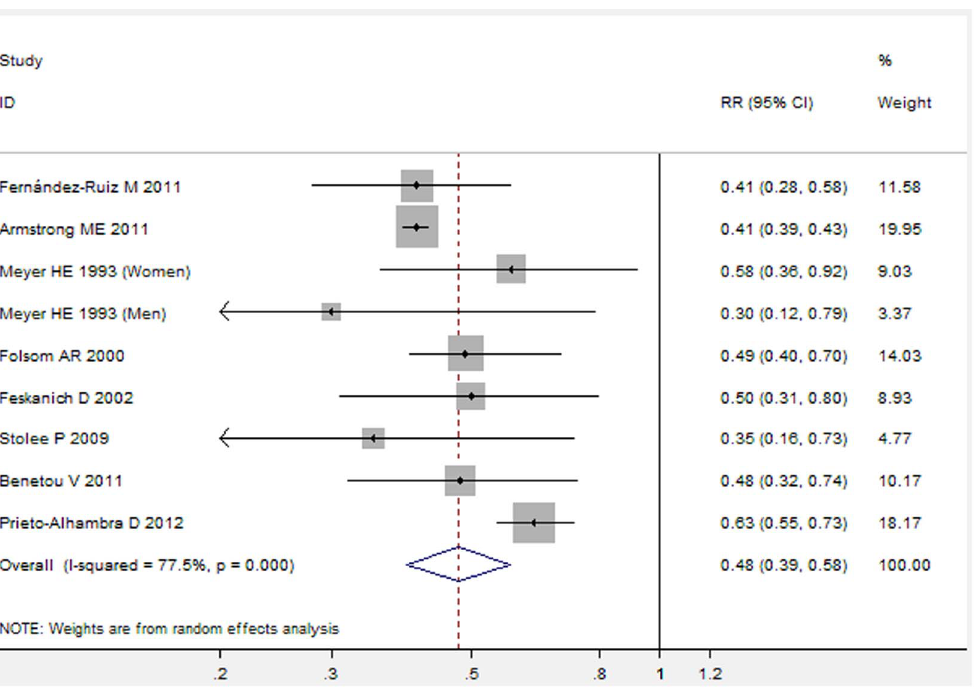
Figure 2. Forest plot showed an association between adult obesity and decreased risk of hip fracture (Analysis of adjusted RRs).